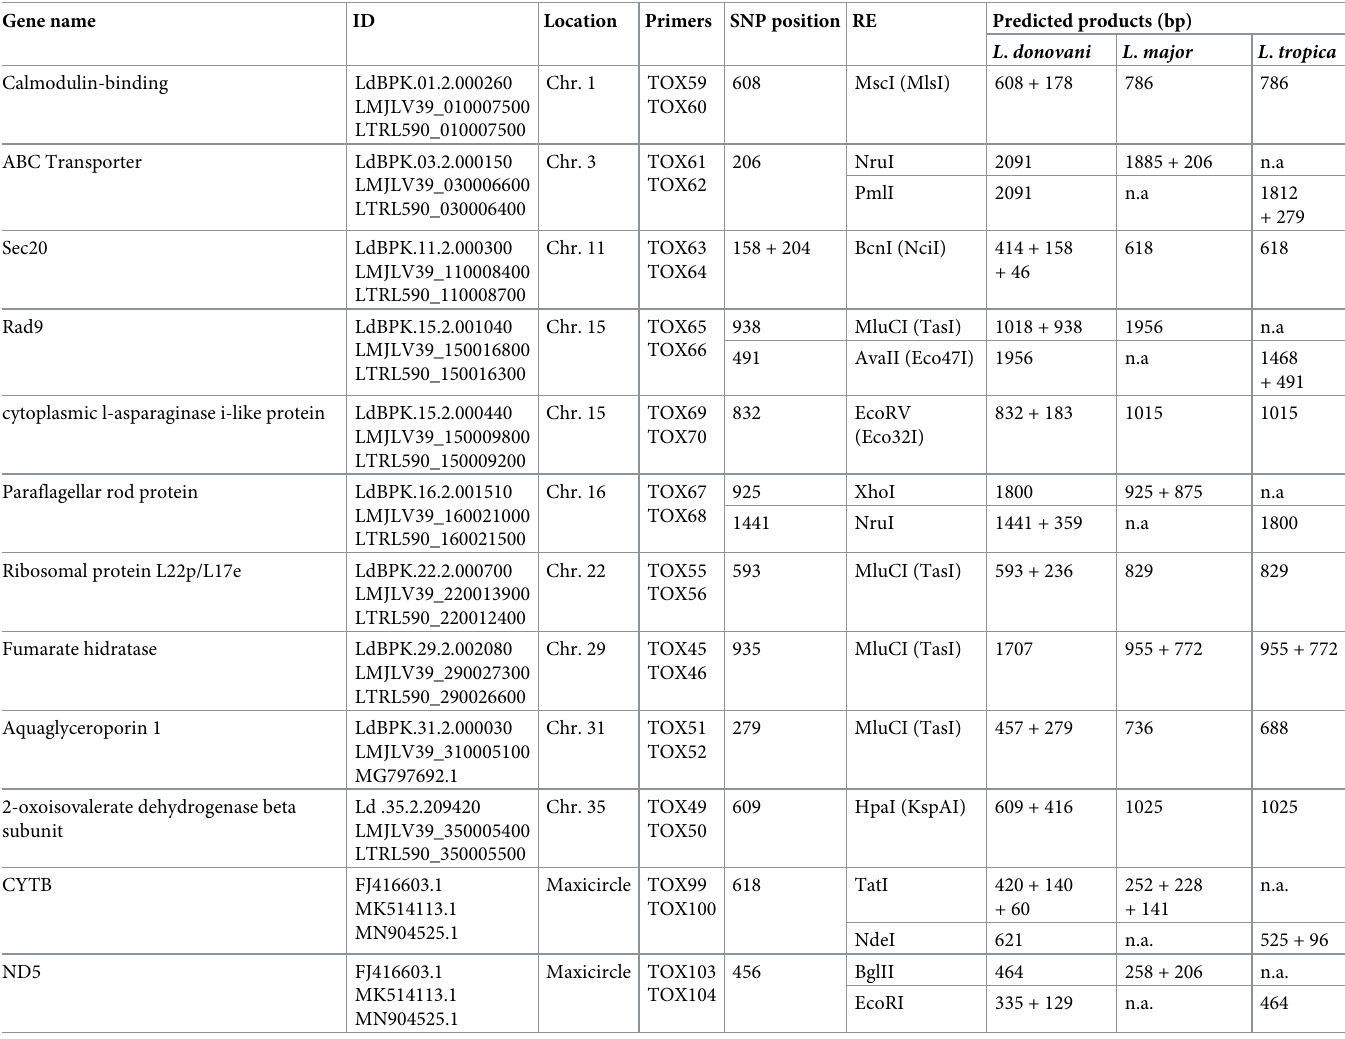
Table 2. Genes tested by SNP-CAPs. The gene name, gene identification (ID), location, the name of forward and reverse primers used for PCR amplification (sequence of these primers can be found in Table 1), SNP position, as well as the expected band sizes after digestion with the suitable restriction enzymes, are